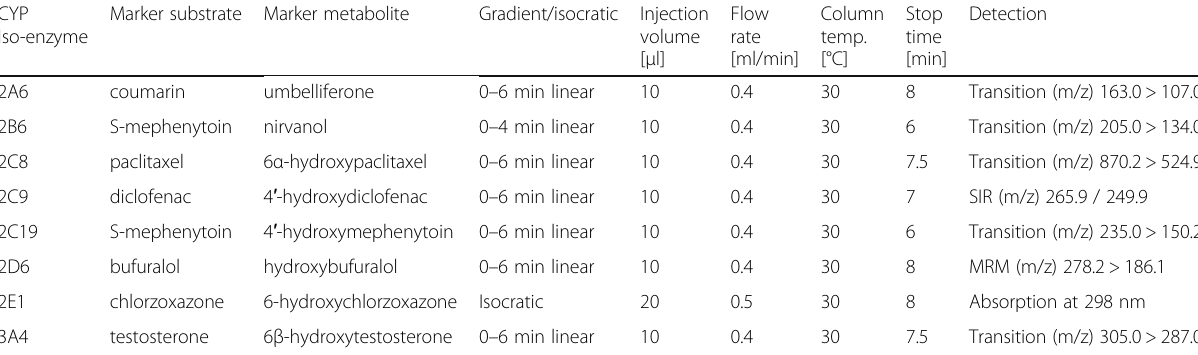
Table 1 HPLC / MS parameters for marker substrate and marker metabolite separation and detection CYP Marker substrate Marker metabolite Gradient/isocratic Injection Iso-enzyme